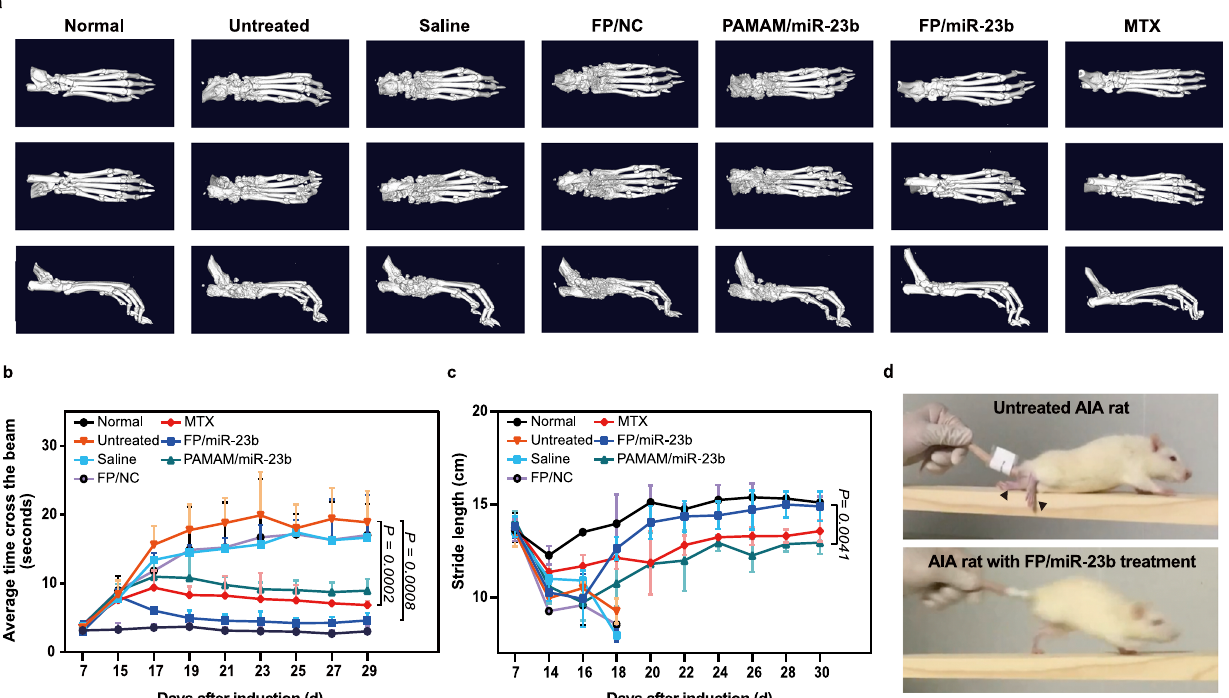
Fig. 6 | Bone function and mobility analysis of AIA rats after the miR-23b delivery. a The representative micro-CT images of arthritis rats after different treatments at day 22 post-adjuvant induction. b The beam walking test assessed duringtheperiodof30-daypost-adjuvantinduction,inwhichthetimetocrossthe 1-m beam was recorded. c Stride length measured by the distance of hind paws during the period of 30-day post-adjuvant induction. The rats in untreated, saline